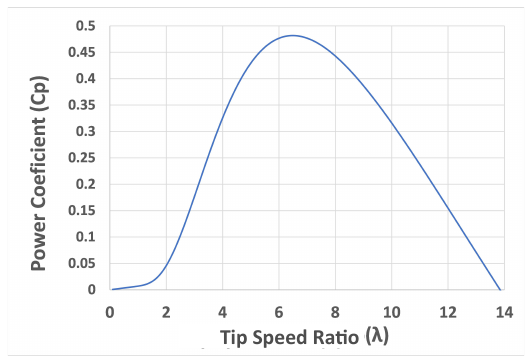
Figure 1. Power coefficient vs. tip speed ratio